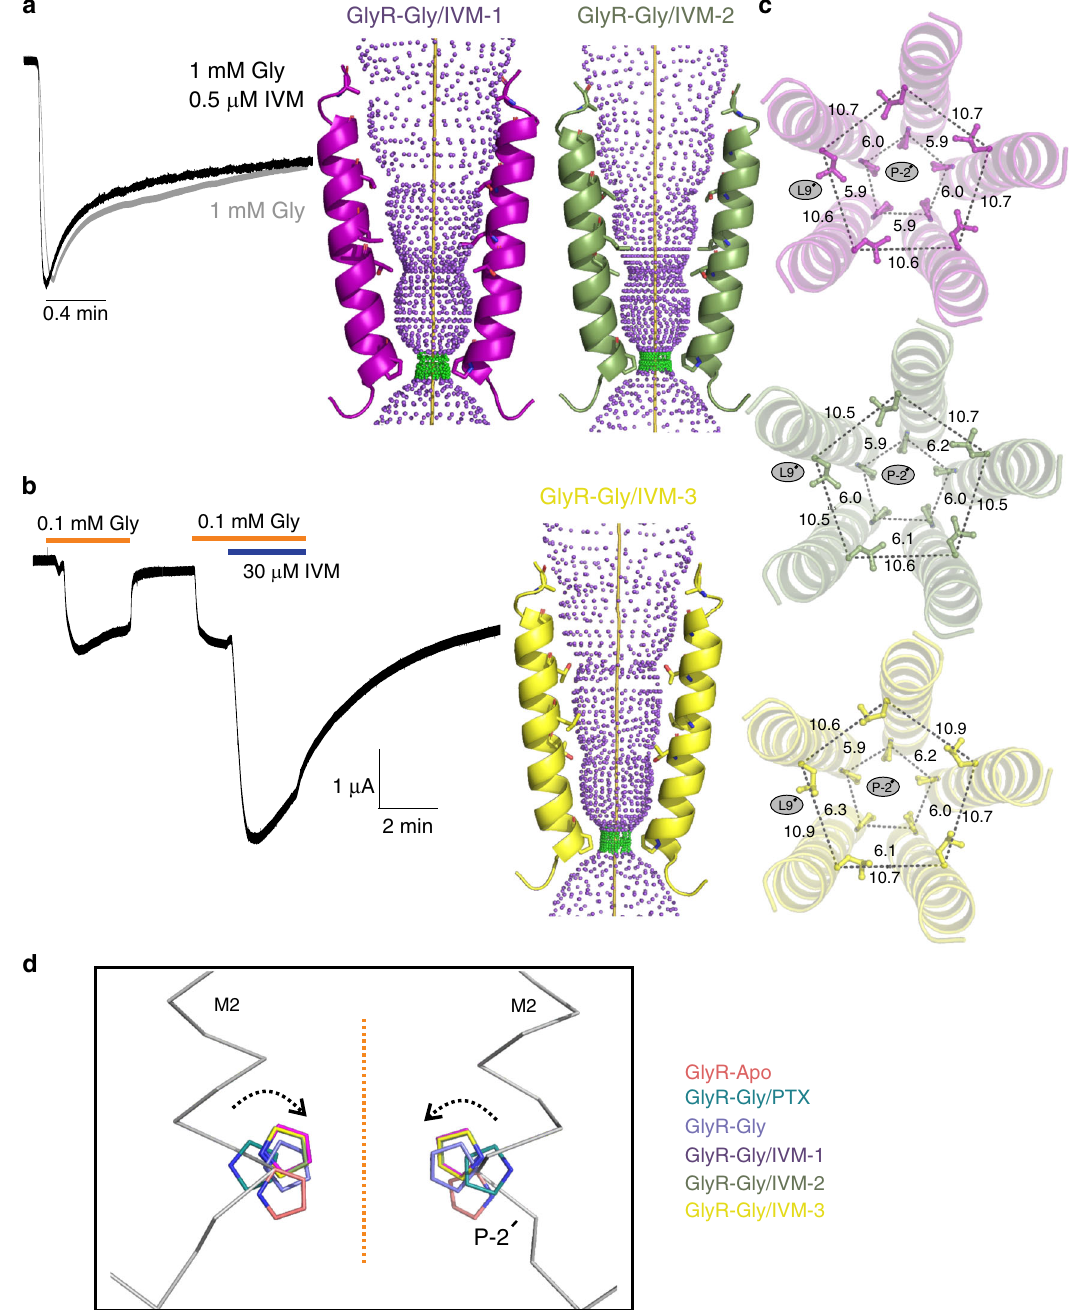
Fig. 5 Analysis of GlyR – Gly/IVM structures. a TEVC recording of 1 mM glycine-induced currents in the presence and absence of 0.5 μ M IVM (left). Representative trace from multiple independent oocyte recordings ( n = 5). The traces are normalized to the peak current to show the current decay. Ion permeation pathway for GlyR – Gly/IVM-1 GlyR – Gly/IVM-2 (right). Green and purple spheres de fi ne radii of 1.8 – 3.3 Å and >3.3 Å, respectively. The residues located at various pore constrictions are shown as sticks. b Current recording for 0.1 mM glycine and 0.1 mM glycine and 30 μ M IVM (left). Representative trace from multiple independent oocyte recordings ( n = 3). The pore pro fi le for GlyR – Gly/IVM-3 structure. c A view of M2 helices from the extracellular end Positions Leu9 ′ and Pro-2 ′ and the corresponding distances between C α in Å. d Alignment of GlyR structures showing the conformational differences at the level of Pro-2 ′ . Dotted arrows indicate the direction of rotation going from the GlyR – Apo (closed) to the GlyR – Gly (desensitized)